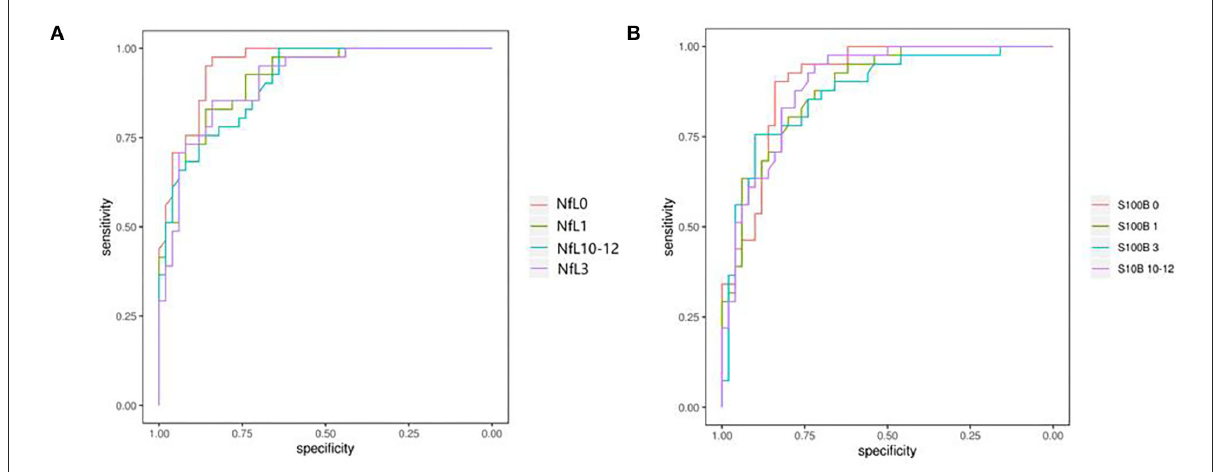
FIGURE5 (A,B) Receiver operating characteristics revealed a sensitivity/specificity of NfL and S100B. The areas under curves for the levels of NfL and S100B in the serum were 0.959 and 0.912, respectively; the clinical diagnostic critical points were 14.275 and 26.54 pg/ml, respectively; sensibilities were 0.974 and 0.921, respectively, and specificities were 0.849 and 0.811,